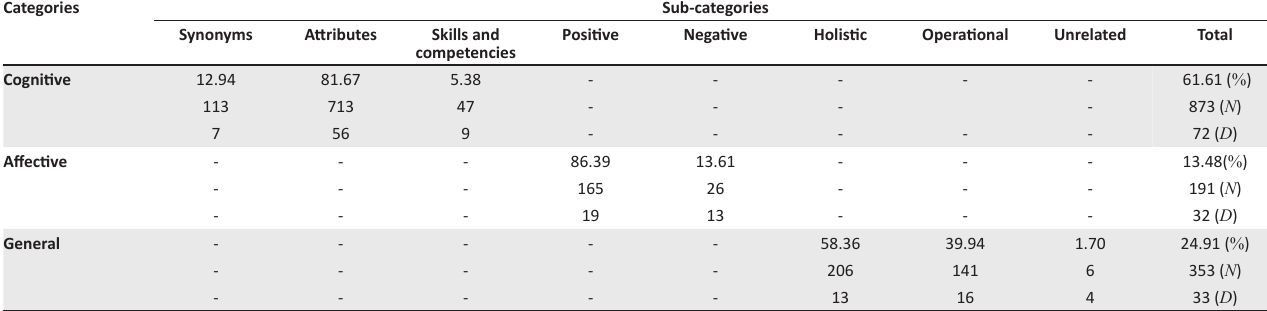
TABLE 1: Word association categories and sub-categories ( n =